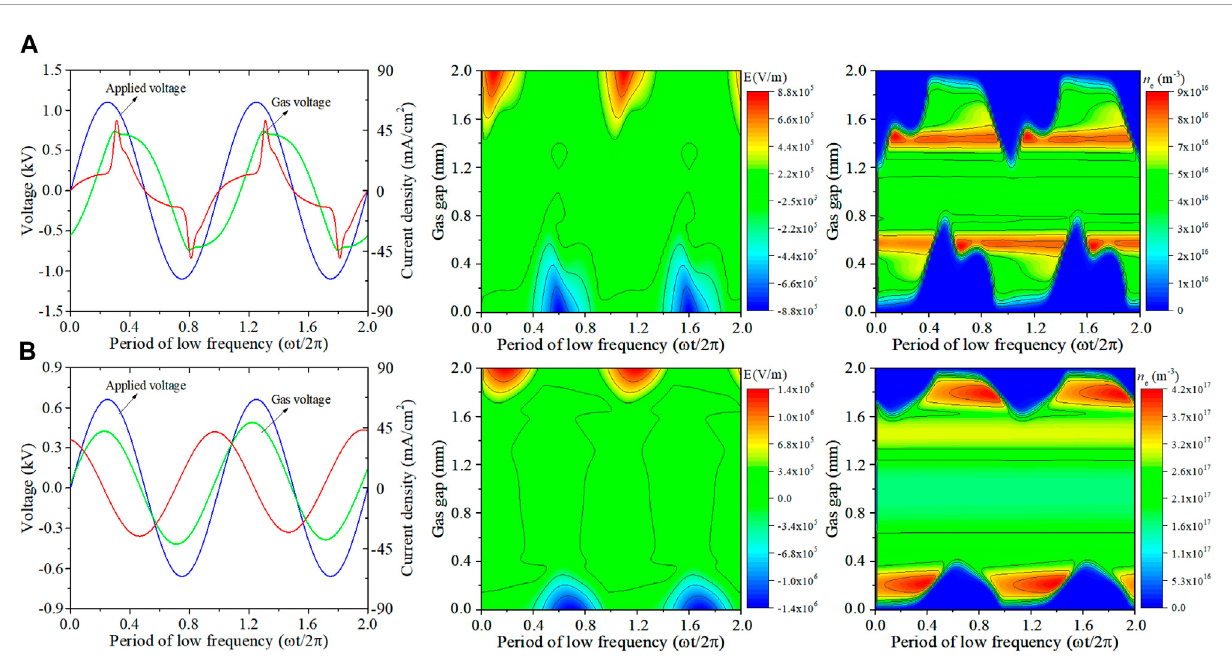
FIGURE 2 Time-dependence of the discharge voltage – current characteristic, electric fi eld, and electron density, respectively, in the low-frequency-only discharge of 50 kHz@1.2 kV (A) and in the high-frequency-only discharge of 5 MHz@0.7 kV (B) .